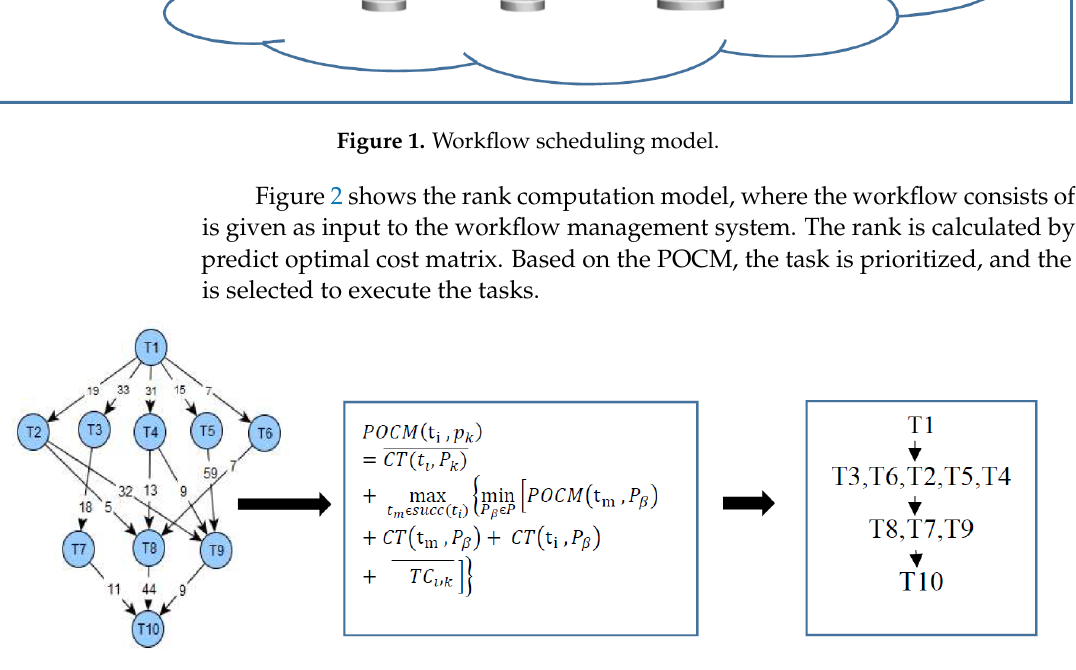
Figure 2. Rank computation model.